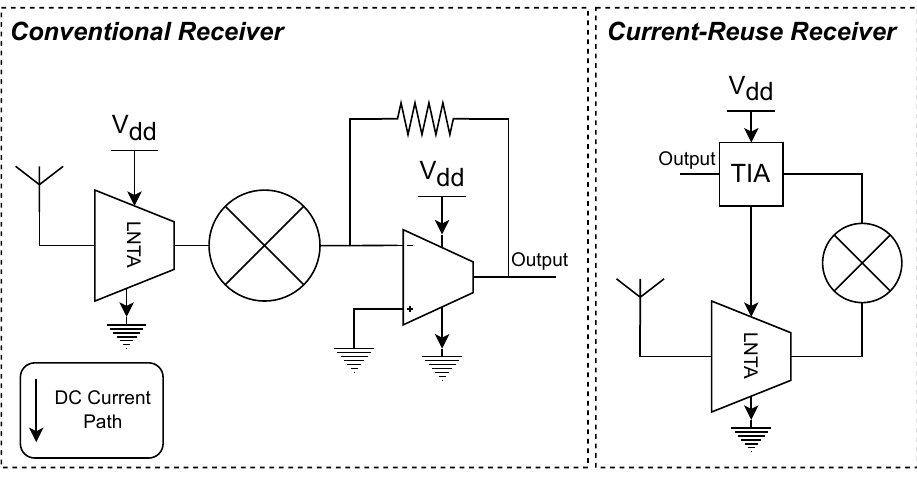
Figure 1. Conventional ( left ) and current-reuse ( right ) receiver